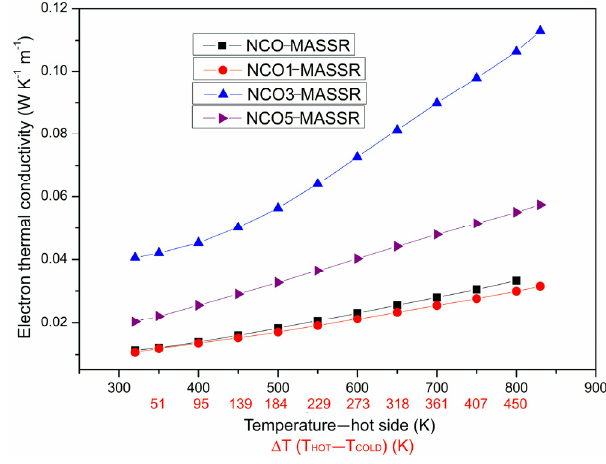
Figure 5. Electron thermal conductivity of MASSR samples for the temperature gradients Δ T at the temperatures of the hot side of the samples.